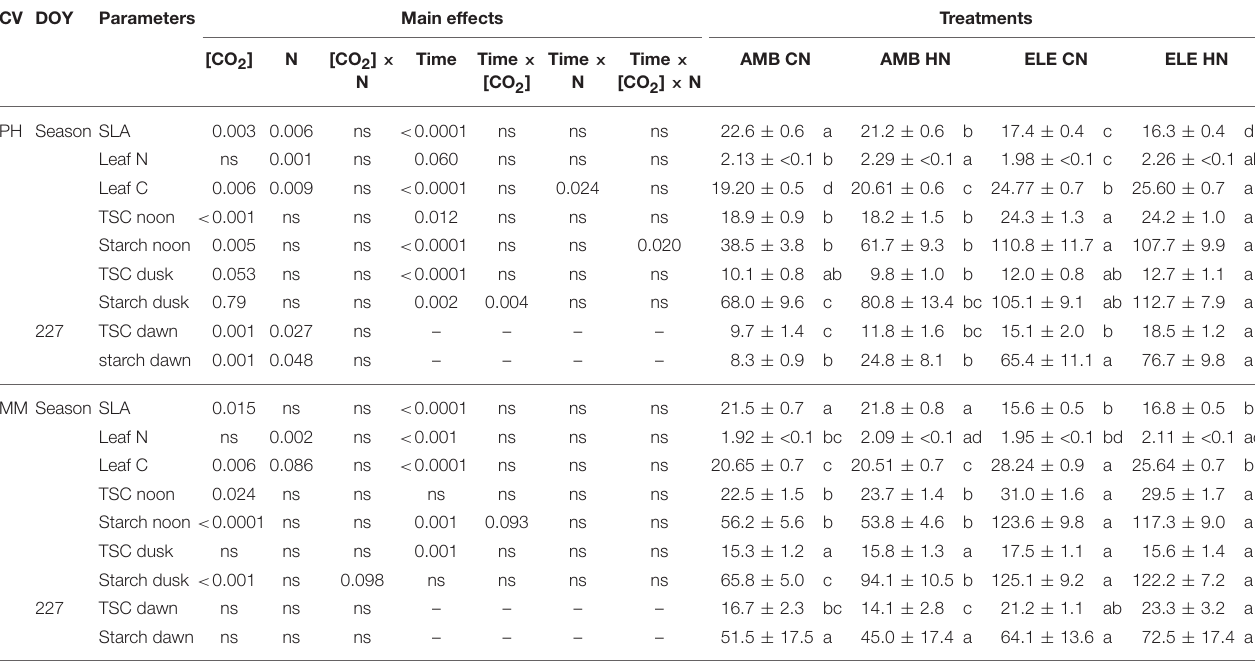
The ANOVA table also includes the daily analysis of TSC and starch at dawn, no repeated measurements. The statistically significant differences (p < 0.1) and non-statistical significance (ns) are shown in the table. On the right side, values represent day of the year (DOY) and season averages ± standard deviation of the same parameters. Treatments with different letters represent statistically significant differences (p <